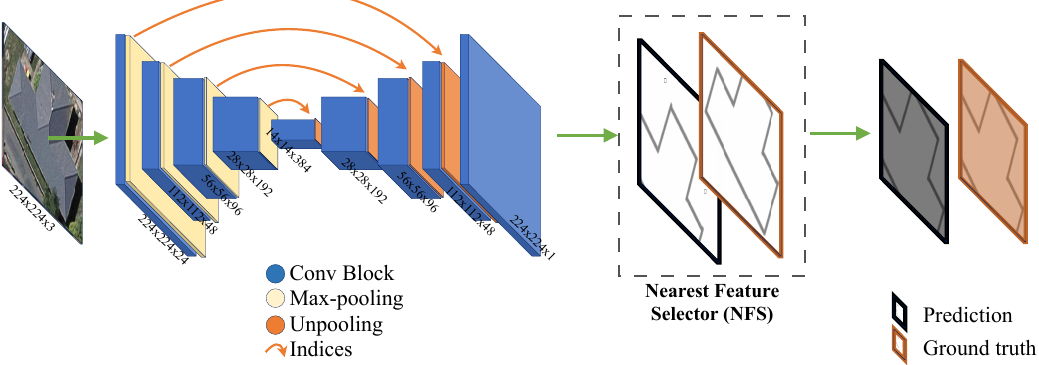
Figure 4. Overview of the proposed model. The model consists of a modified SegNet for feature extraction and the nearest feature selector (NFS) module for dynamic